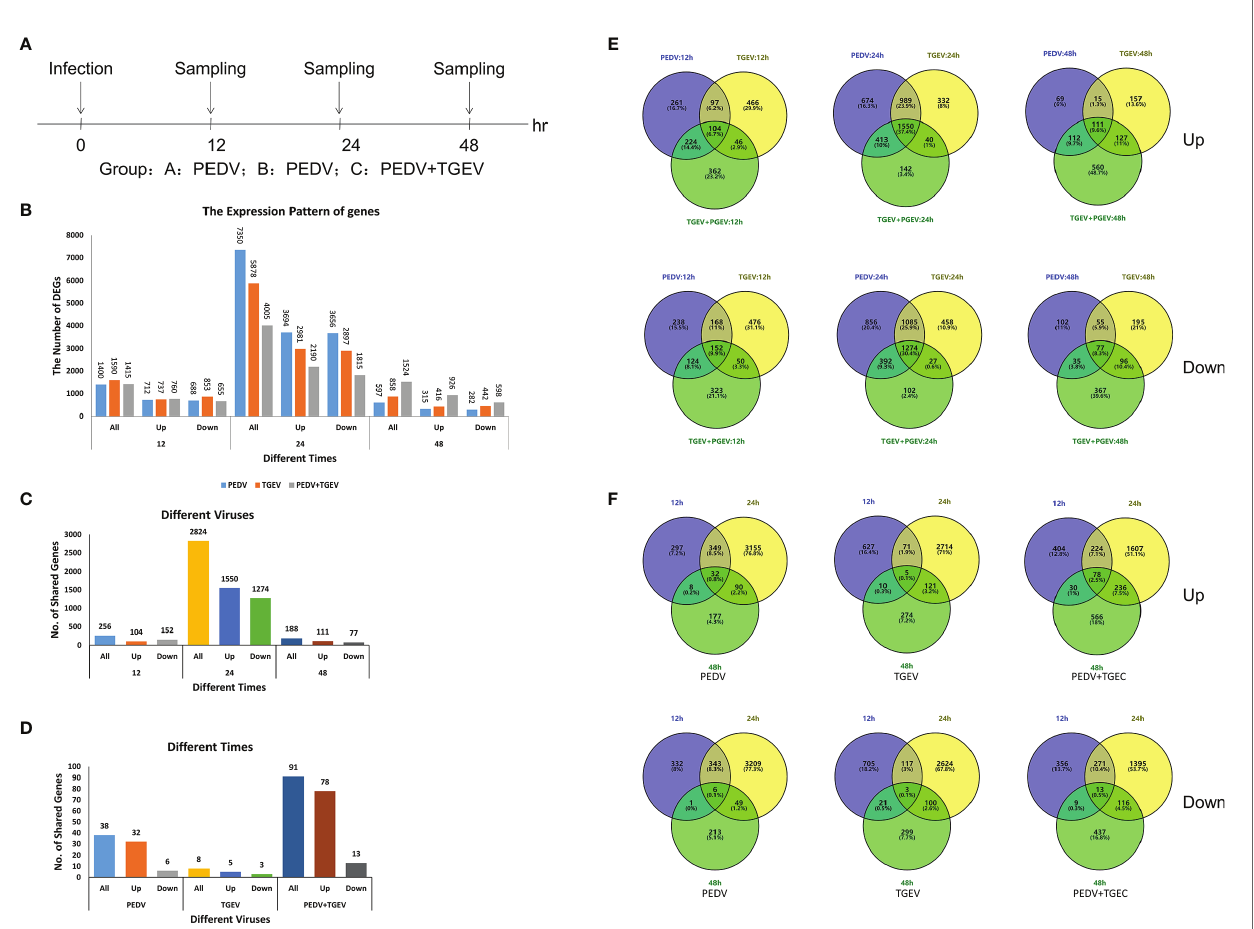
FIGURE 2 | The differentially expressed genes in all transcriptome groups. (A) Schematic diagram of sampling. (B) The number of DEGs at different times. (C, E) DEGs of different groups at different times. (D, F) DEGs of the coinfected group at different